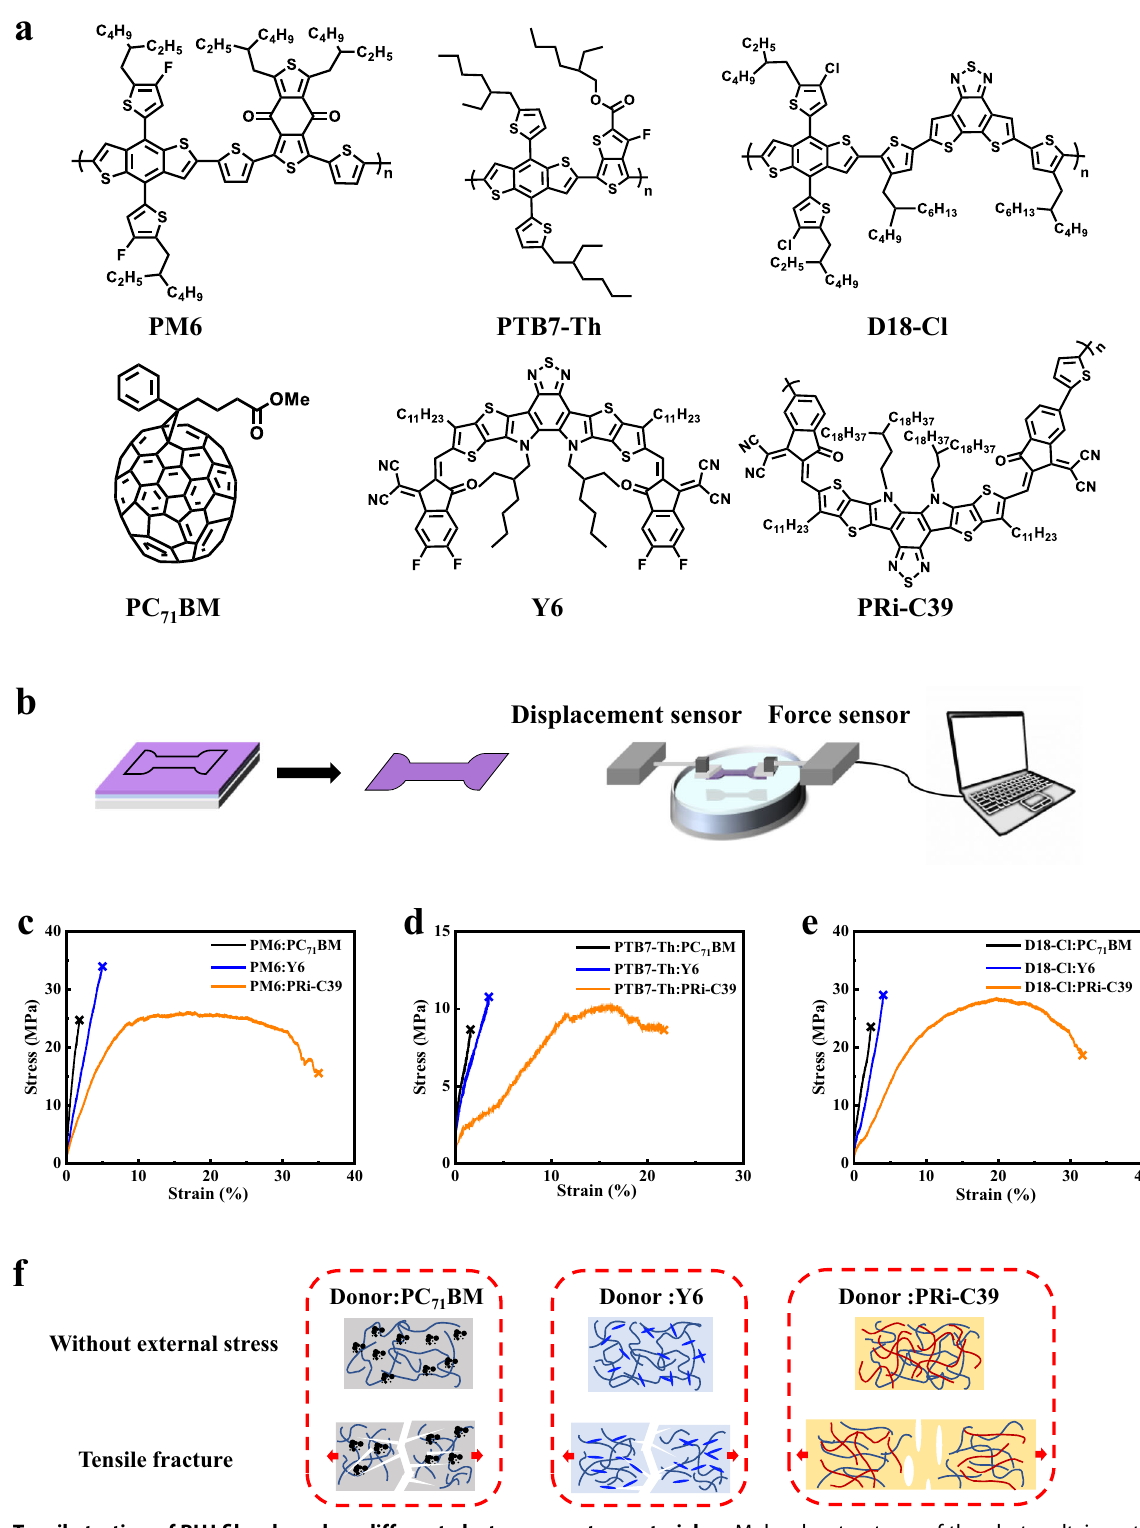
Fig. 1 Tensile testing of BHJ fi lms based on different electron acceptor materials. a Molecular structures of the photovoltaic materials used in the study. b Schematic illustration of the tensile test of fi lms on water. The fi lm is fi rstly spin-coated on the substrate, then etched into a dog-bone shape by laser etching, and fi nally, a high-precision force sensor and a linear displacement stage are used for data acquisition. The stress-strain curves of c PM6, d PTB7-Th, and e D18-Cl-based blend layers. f Schematic diagram of the fi lms under no stress and